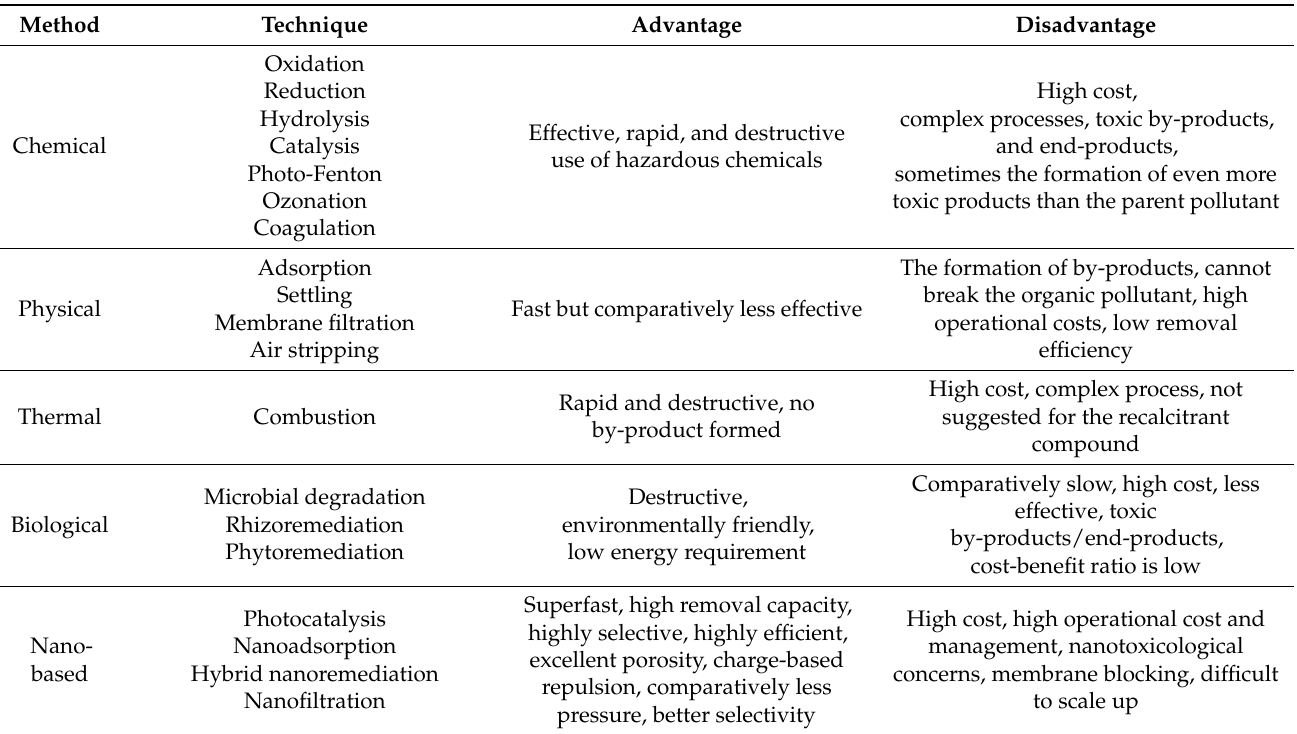
Table 2. Comparison between conventional and advanced nanotechnological processes.